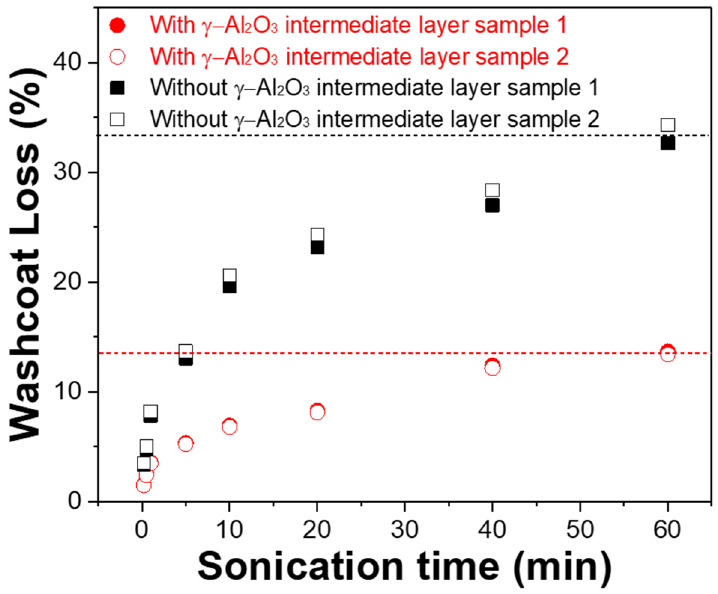
Figure 4. Washcoat loss of Pt/ γ -Al 2 O 3 catalyst with and without the γ -Al 2 O 3 intermediate layer on STS-444 substrate.